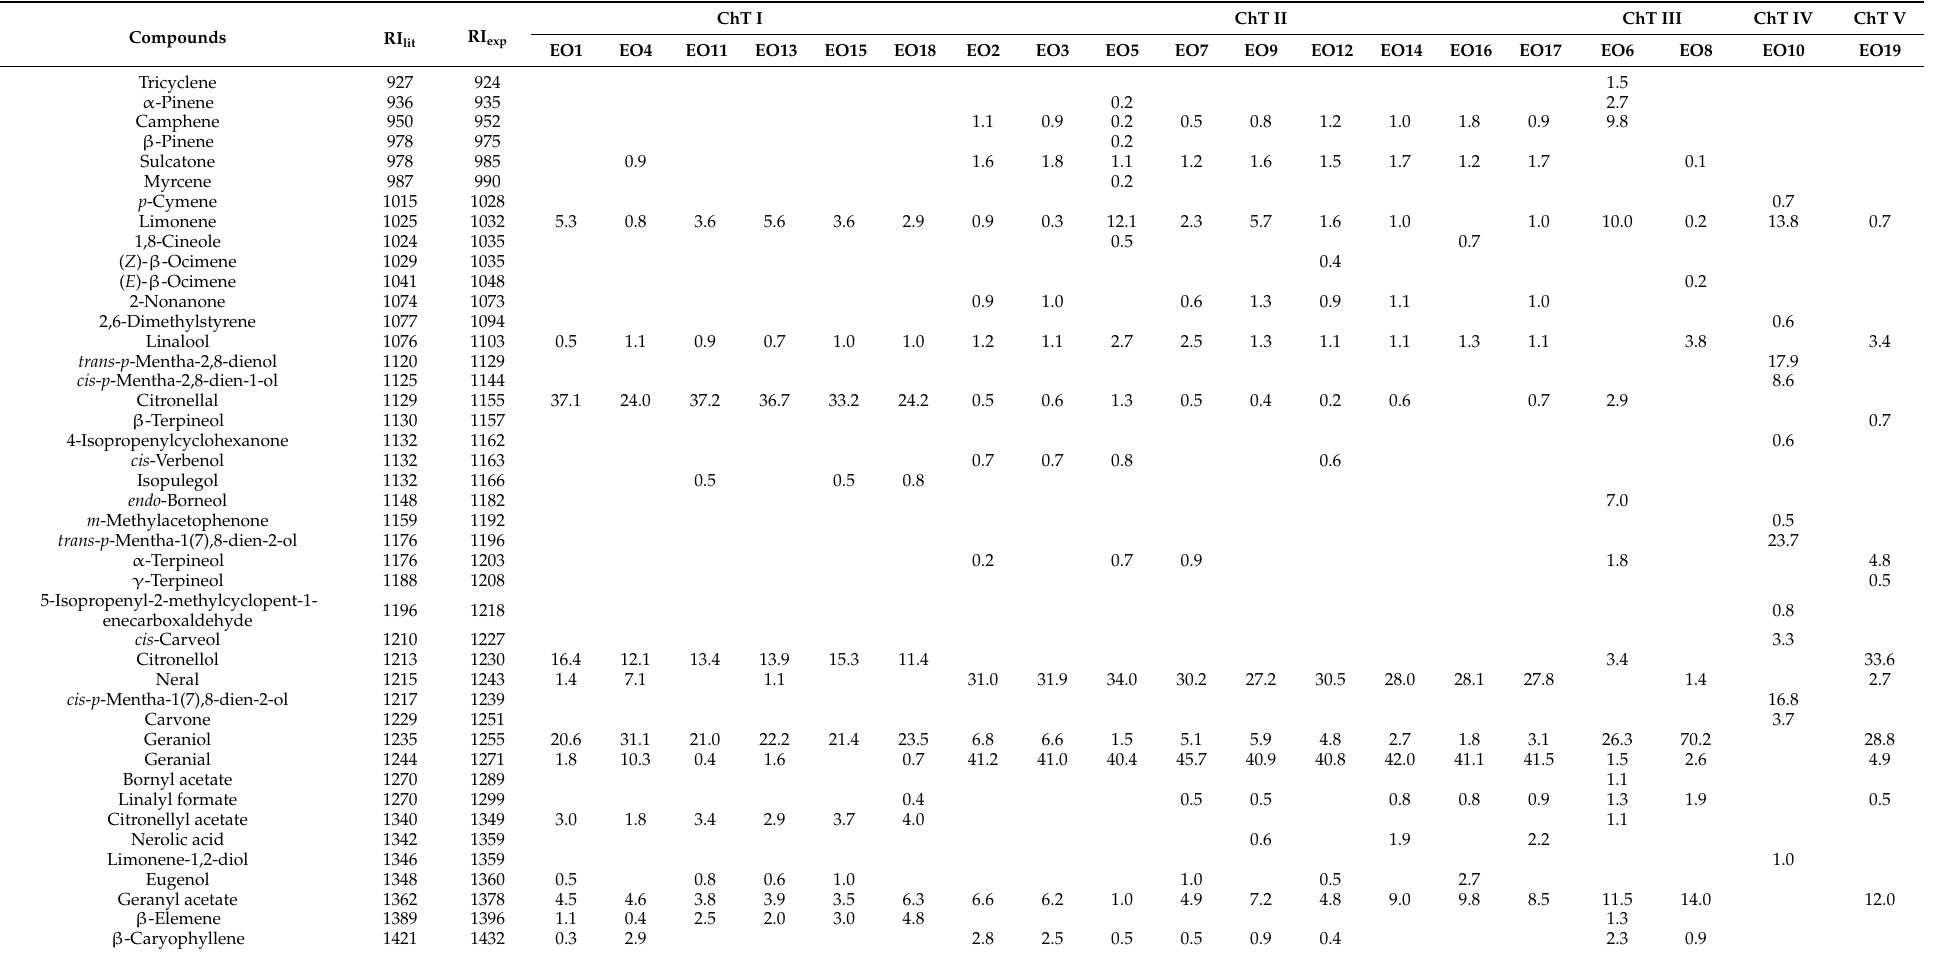
Table 1. Relative percentages of volatile components identified in the examined essential oils. Essential oils were sorted according to recognized chemotypes (ChT). For EO numbering, see Table